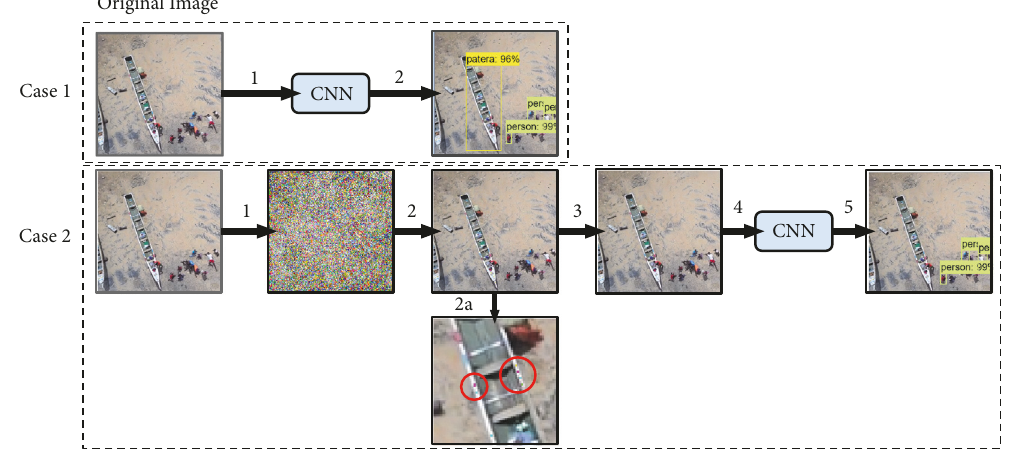
Figure 10: Adversarial attack proof of concept.